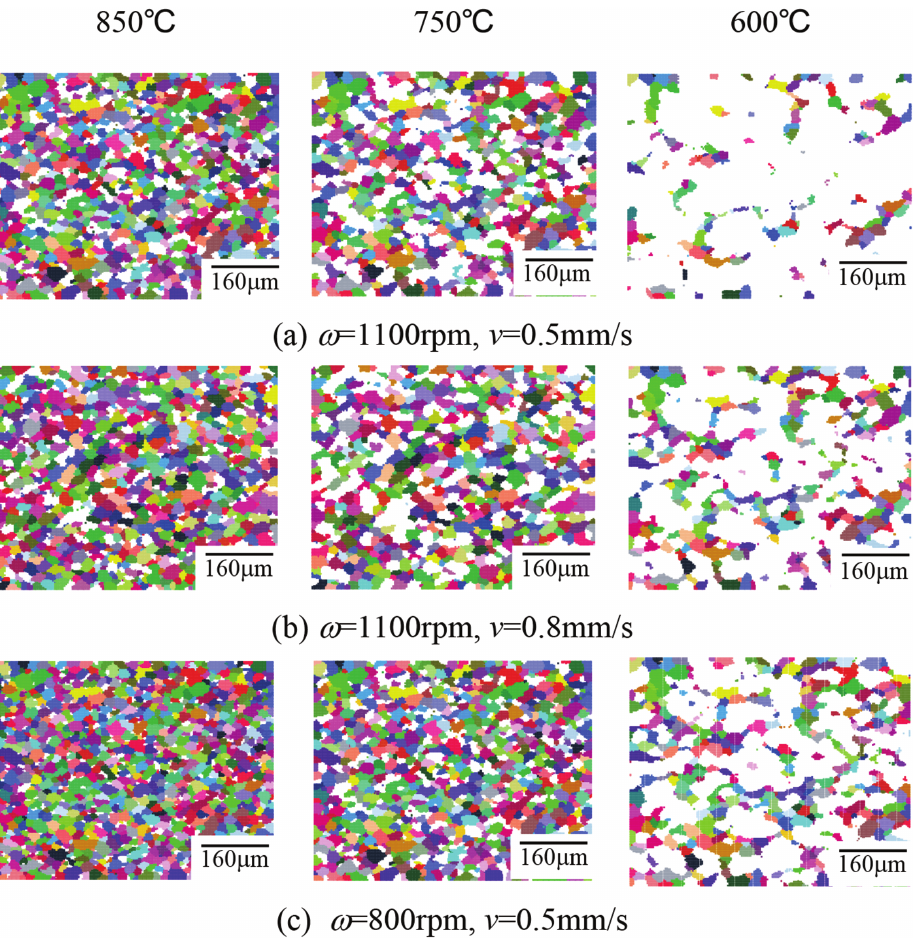
Figure 12: α and β phases during the cooling progresses in different welding